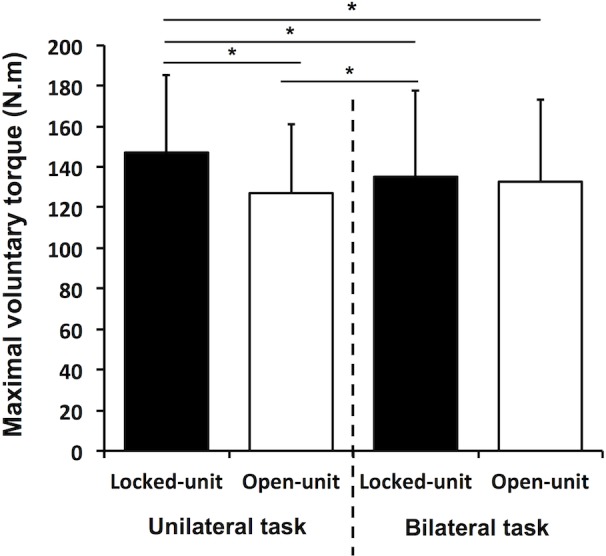
Maximal voluntary torque for the locked-unit (filled bars) and open-unit (open bars) in the unilateral and ‘separated’ bilateral tasks.* Significant difference between conditions (p<0.05).